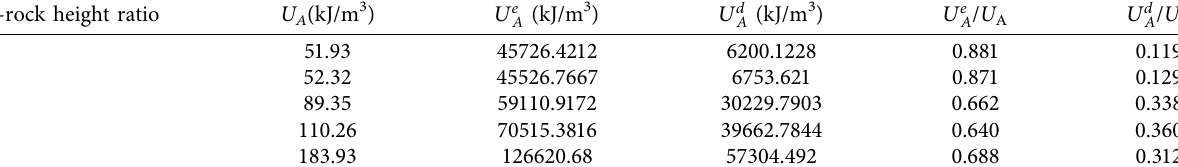
U d A at the peak strength.